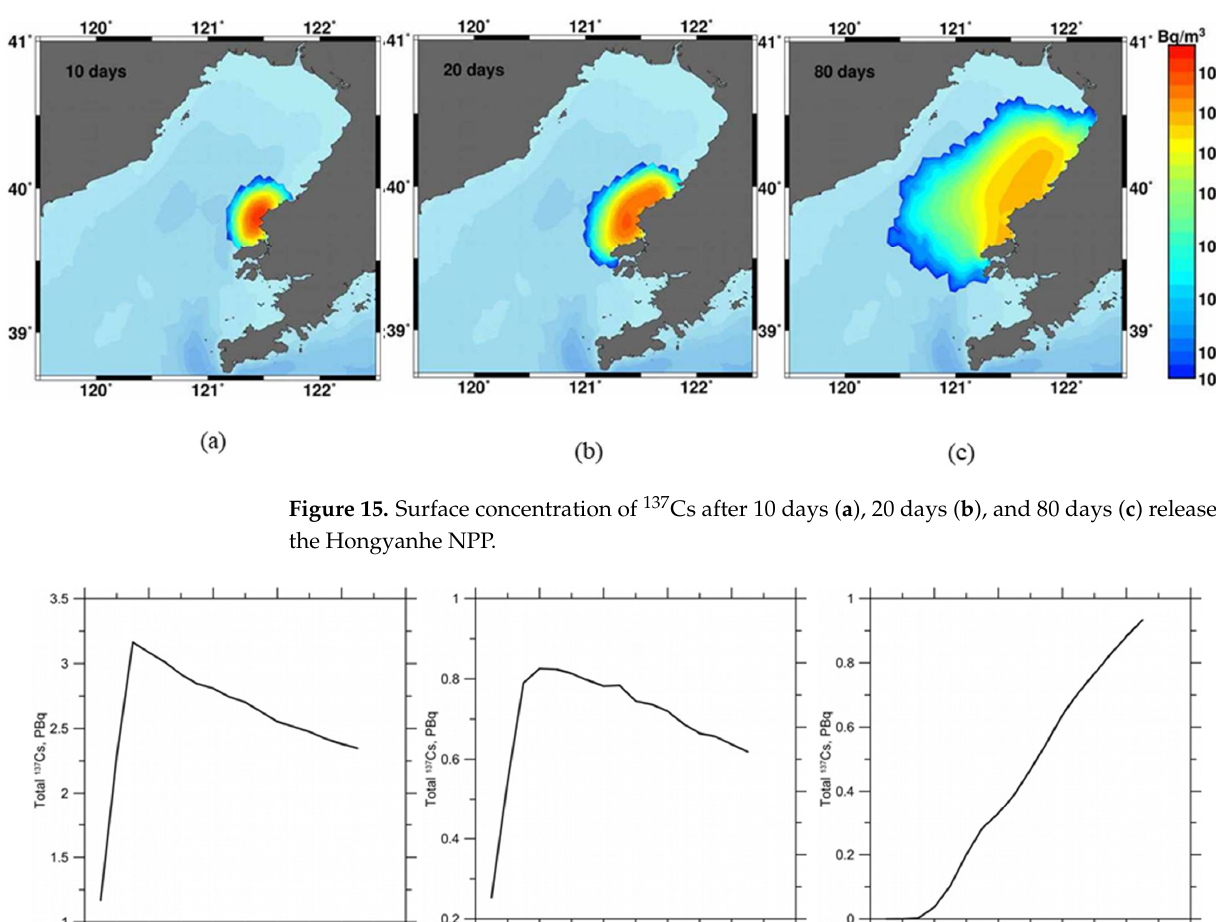
is permanent and one way.